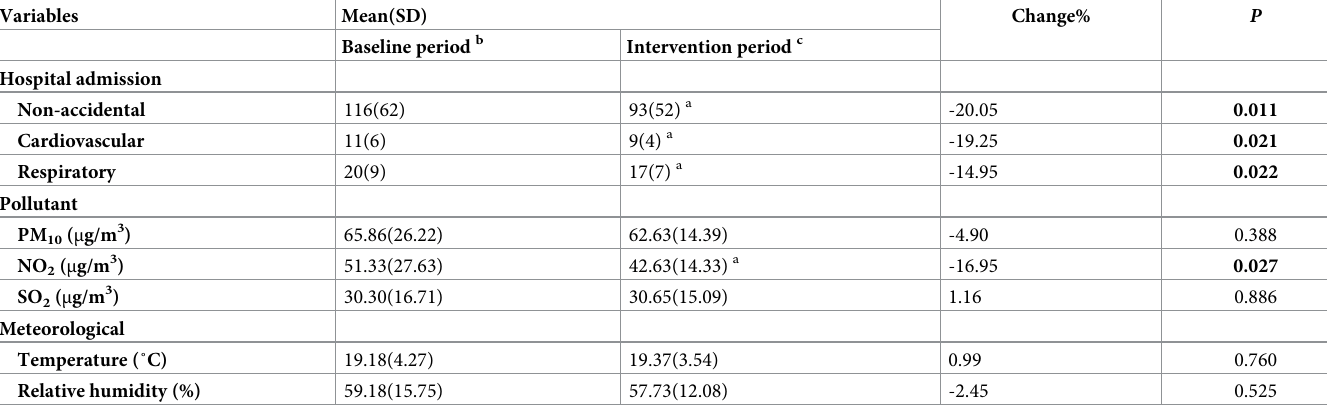
Table 1. Comparison of daily hospital admissions, air pollution and meteorological conditions between the intervention period and the baseline period in Guangzhou. Variables Mean(SD) Change% P Baseline period b Intervention period